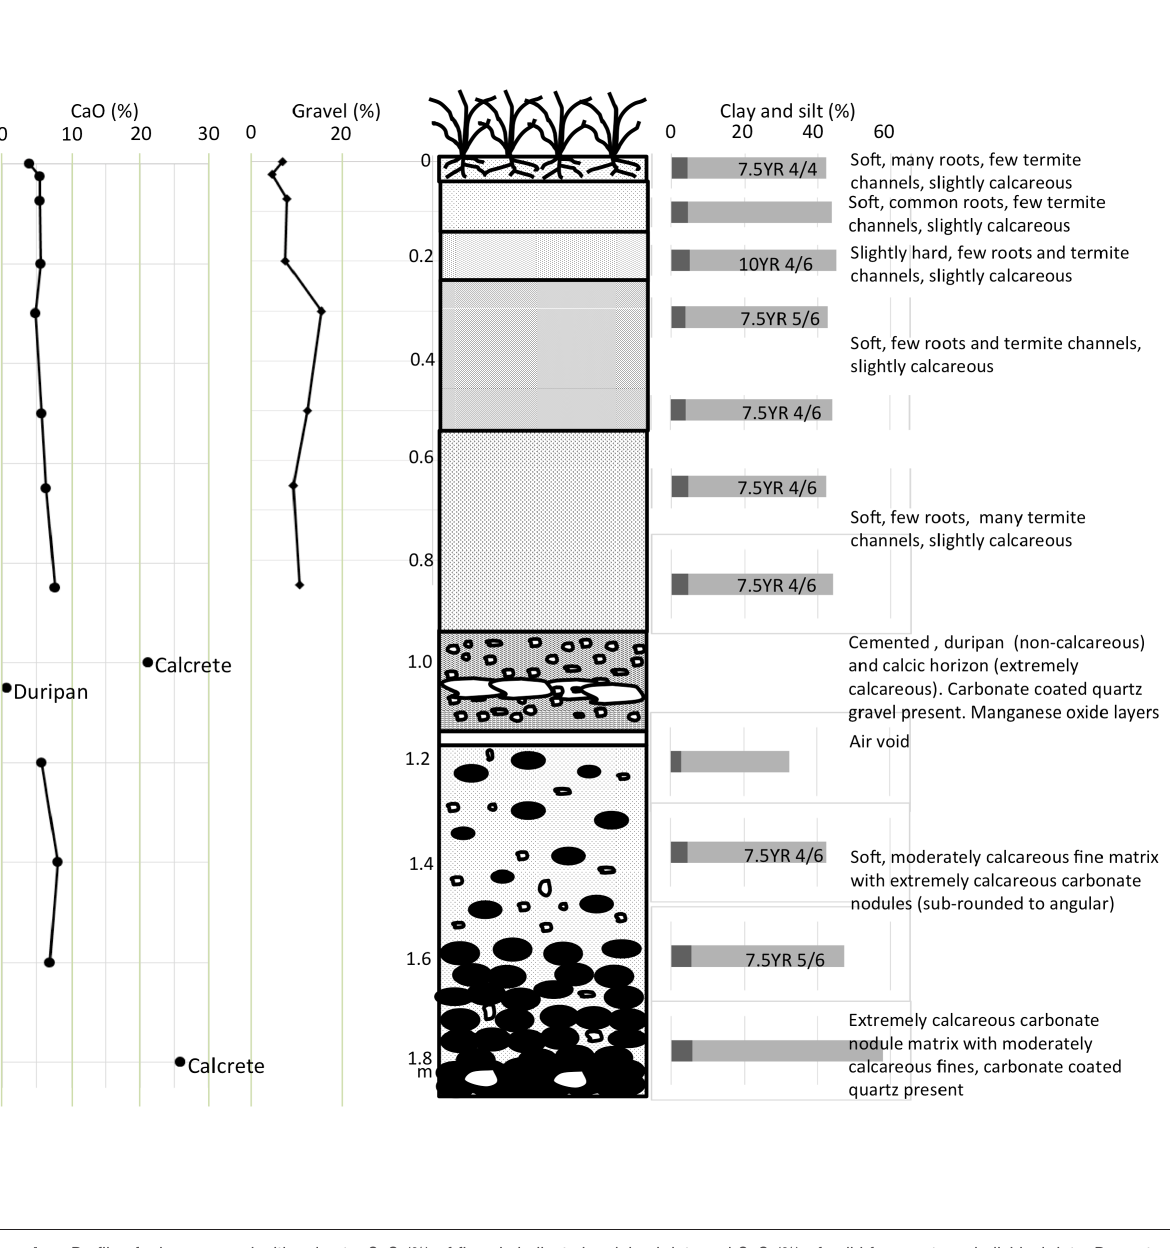
Figure 4: Profile of a large mound with calcrete. CaO (%) of fines is indicated as joined dots and CaO (%) of solid fragments as individual dots. Percentage gravel (% by mass) and proportion of clay and silt of <1 mm fraction (% by volume). Horizon boundaries are gradual in most instances, but illustrated here as abrupt for clarity. Gravel fragments and roots are not drawn to